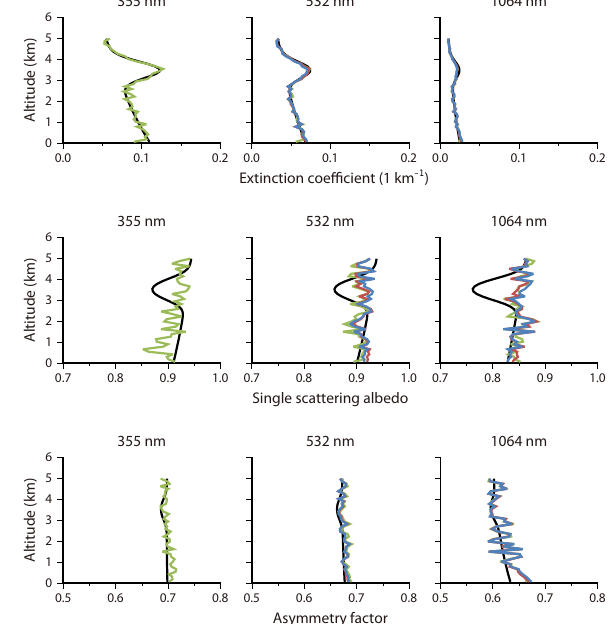
Figure 15. Same as Fig. 13 but showing the retrieval results from the simulated data with random errors for the transported pollution